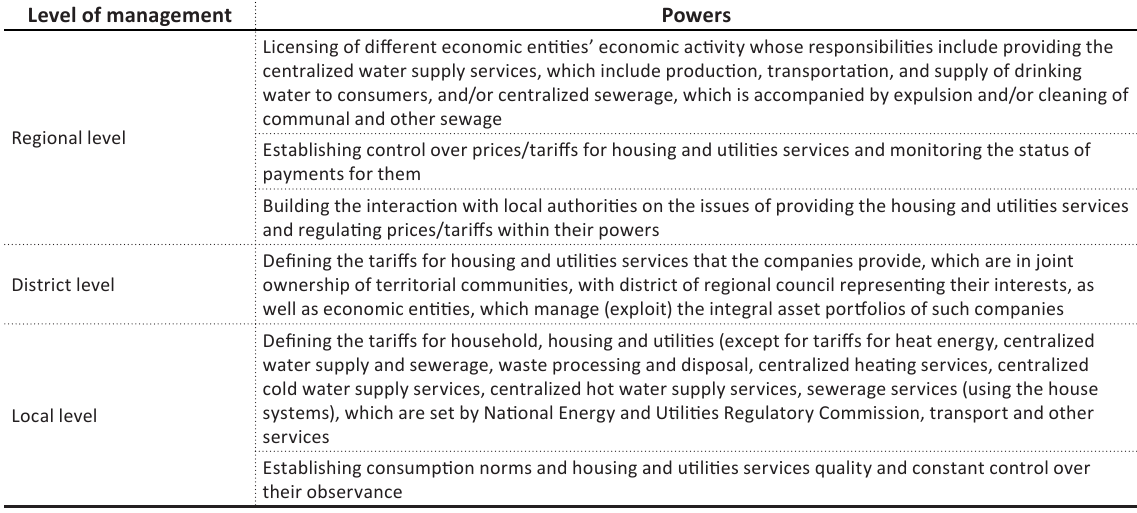
Table 1. Separation of powers at regional, district, and local levels in terms of setting the tariffs for housing and utilities